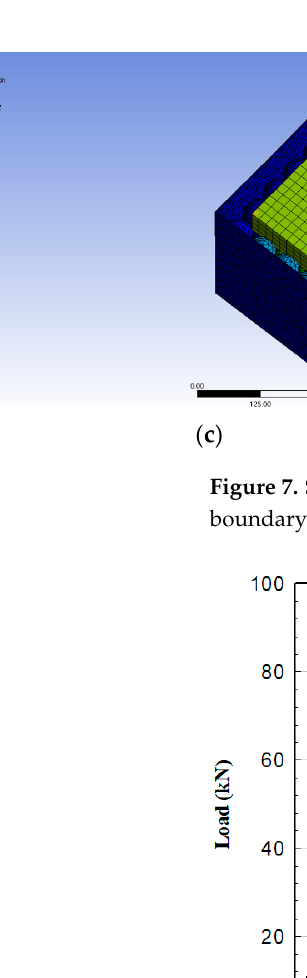
Figure 7. Static numerical analysis examples (250 mm): ( a ) ballast modeling, ( b ) load conditions and boundary conditions, ( c ) normal ballast (displacement), ( d ) coated ballast (displacement), ( e ) normal ballast (stress), and ( f ) coated ballast (stress).